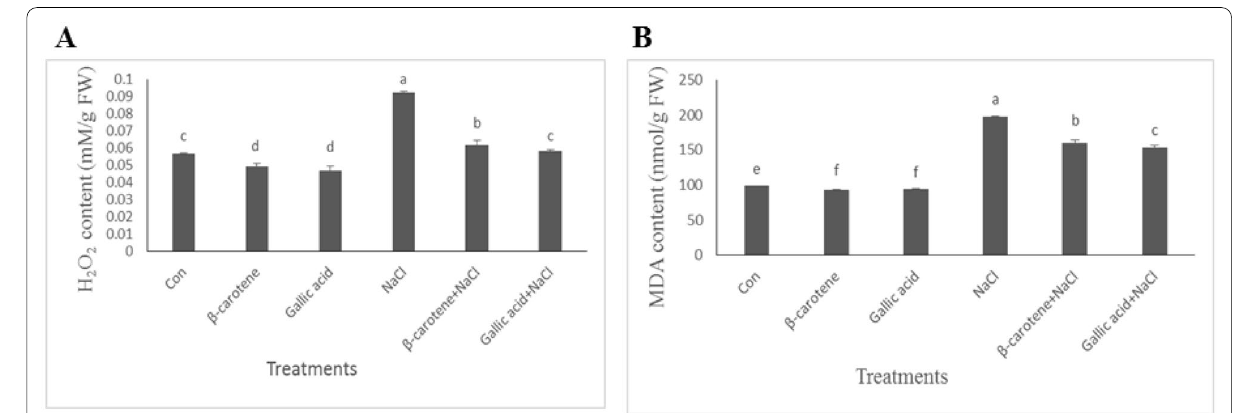
Fig. 4 Effect of β‑carotene and gallic acid, under saline and non‑saline conditions on H 2 O 2 concentration ( A ) and MDA content ( B ) in Lepidium sativum seedlings. Columns with the same letters are not statistically different at 5% probability using Duncan’s